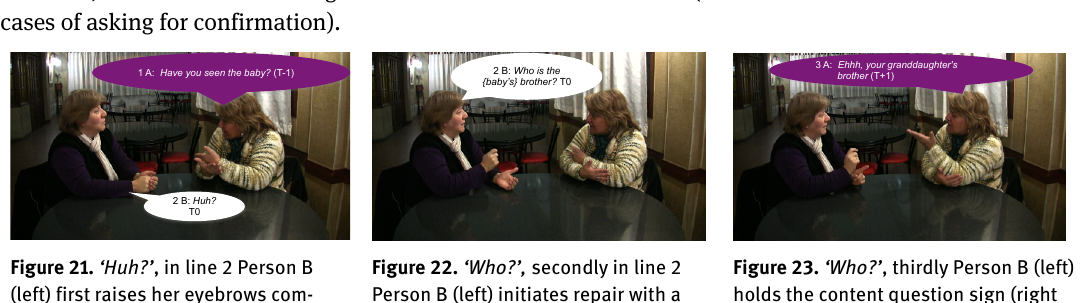
Figure 21. ‘Huh?’ , in line 2 Person B (left) first raises her eyebrows com- bined with a head upward movement.